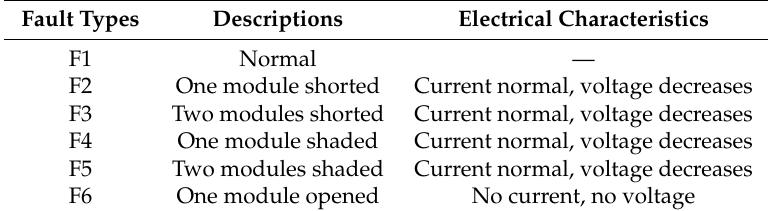
Table 1. PV array fault features.